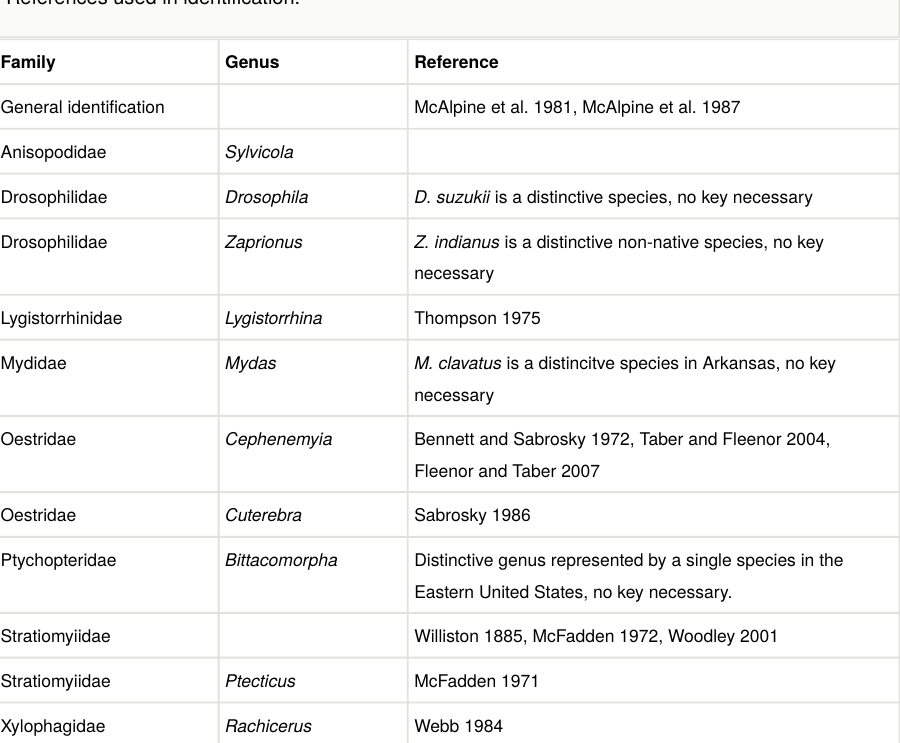
Quality control: Samples were coarse-sorted using a Leica MZ16 stereomicroscope illuminated with a Leica KL1500 LCD light source and a Wild M38 stereomicroscope illuminated with an Applied Scienti fi c Devices Corp. Eco-light 20 fi ber optic light